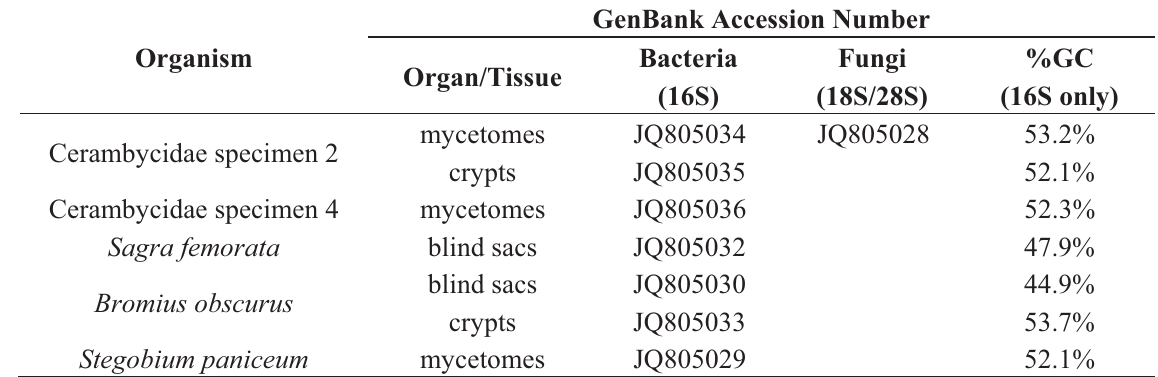
Table 2. Origin, GenBank accession numbers and the relative GC-content (16S rRNA only) of the sequences obtained in the present study